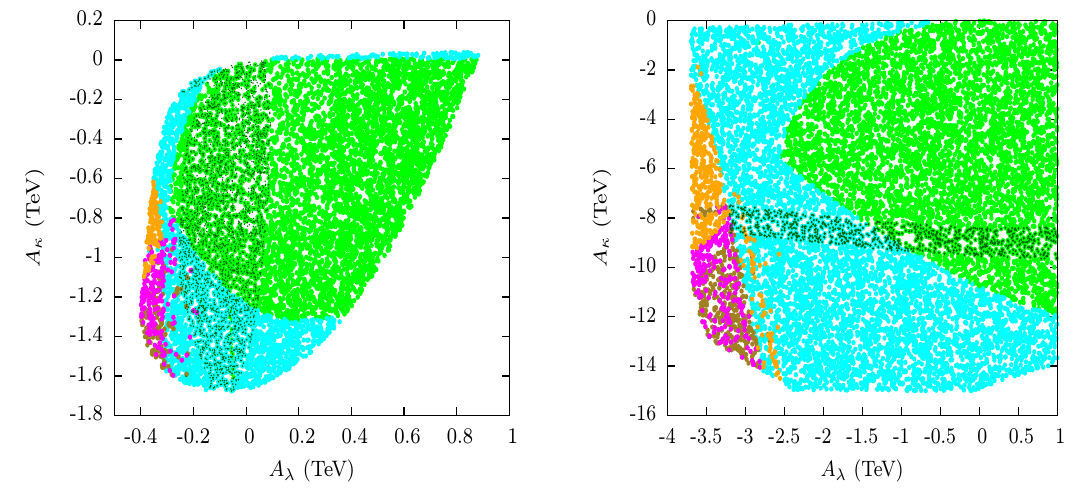
Figure 4 . Scatter plots obtained from a random scan over A (cid:21) and A (cid:20) and showing the stability pattern of the DSB vacuum in the A (cid:21) - A (cid:20) plane for (cid:22) e(cid:11) = 300 GeV (3 TeV) in the left (right)